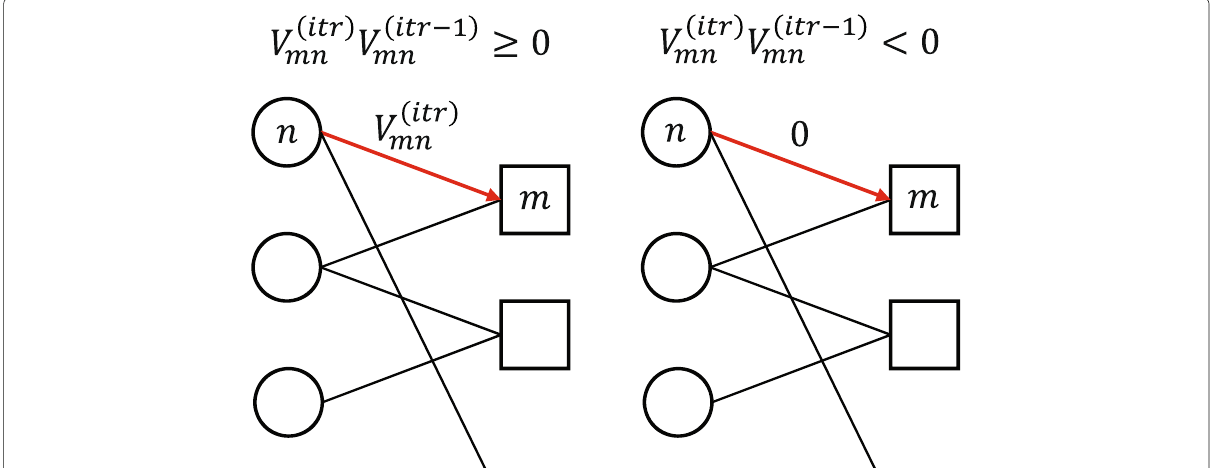
Fig. 2 Behavior of the SC scheme for the min-sum algorithm; variable node to check node (V2C) message that changes its sign between two consecutive iterations is set to zero